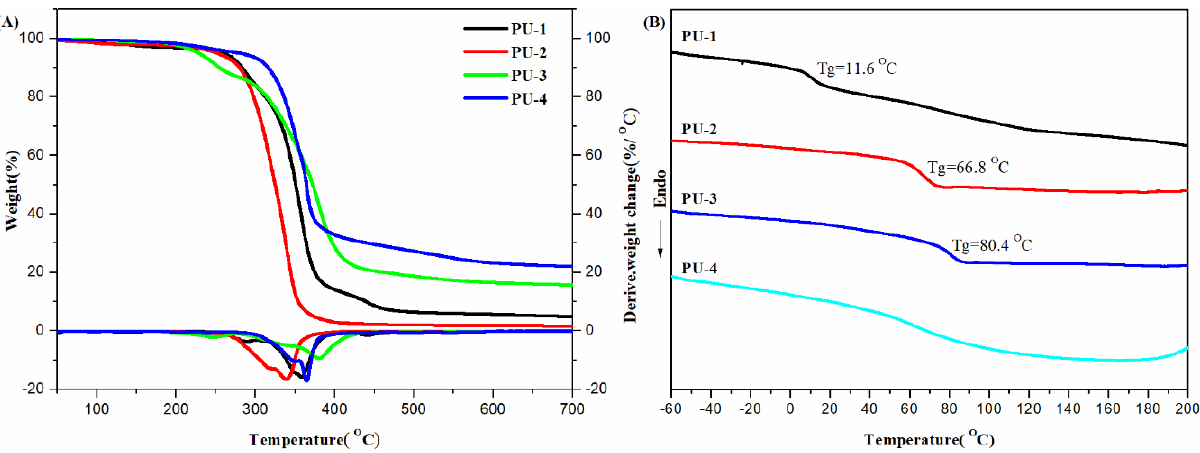
Figure 5. TGA curves ( A ) and differential scanning calorimetry (DSC) traces ( B ) of PUs. Reprinted from [19] with permission of MDPI.